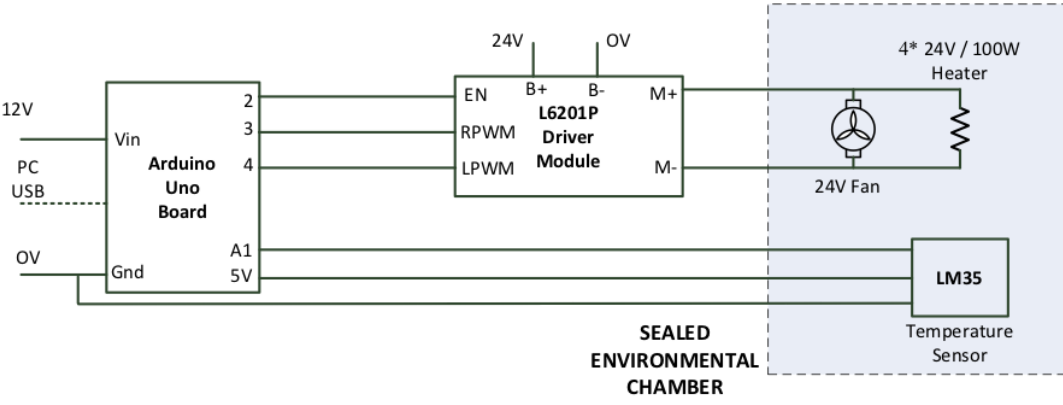
Figure 3. Schematic of the temperature control system.